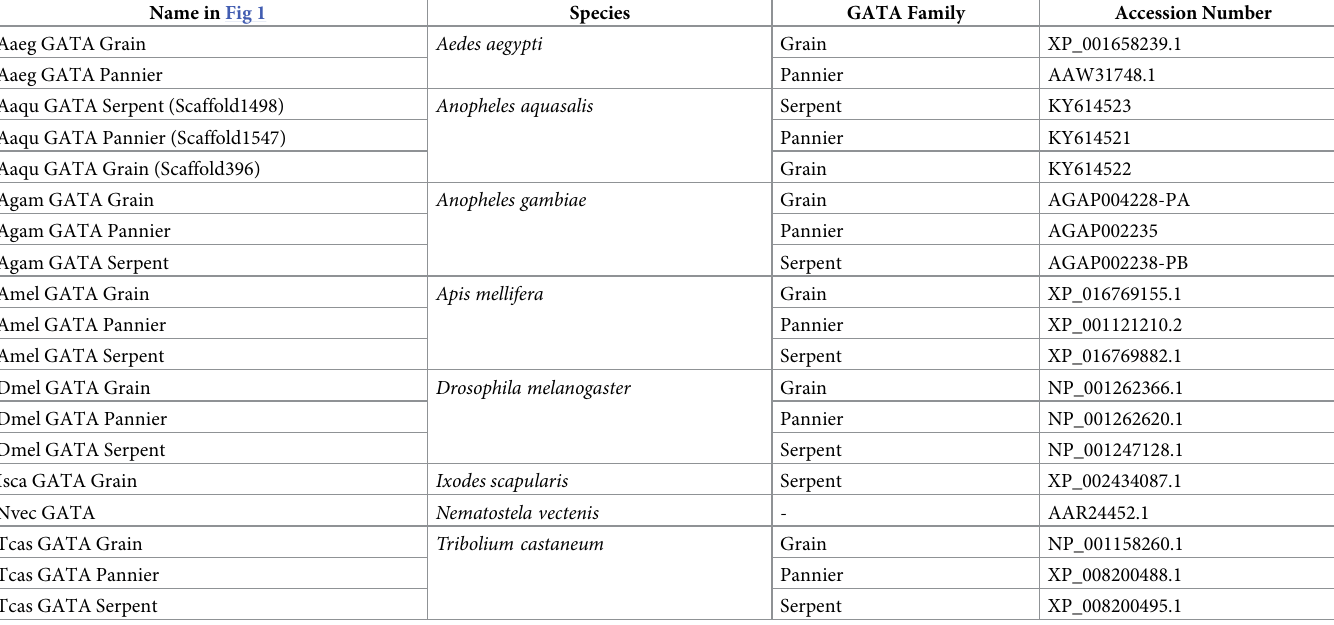
Table 1. Accession numbers of amino acid sequences used for phylogeny analysis of the GATA